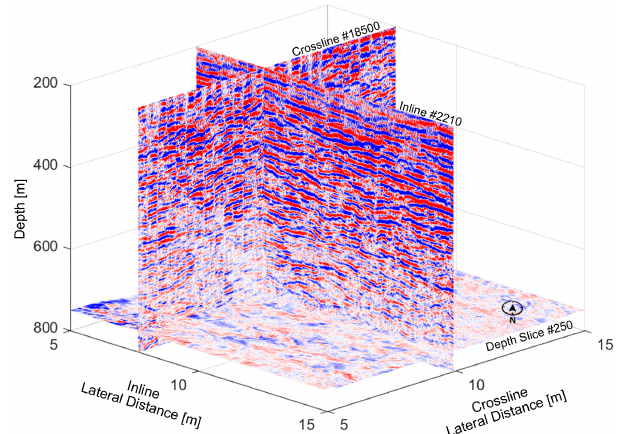
Figure 2. The inline, crossline, and depth-slice configuration in our obtained water-column 3D seismic volume in the Gulf of Mexico. The color represents the amplitude of seismic